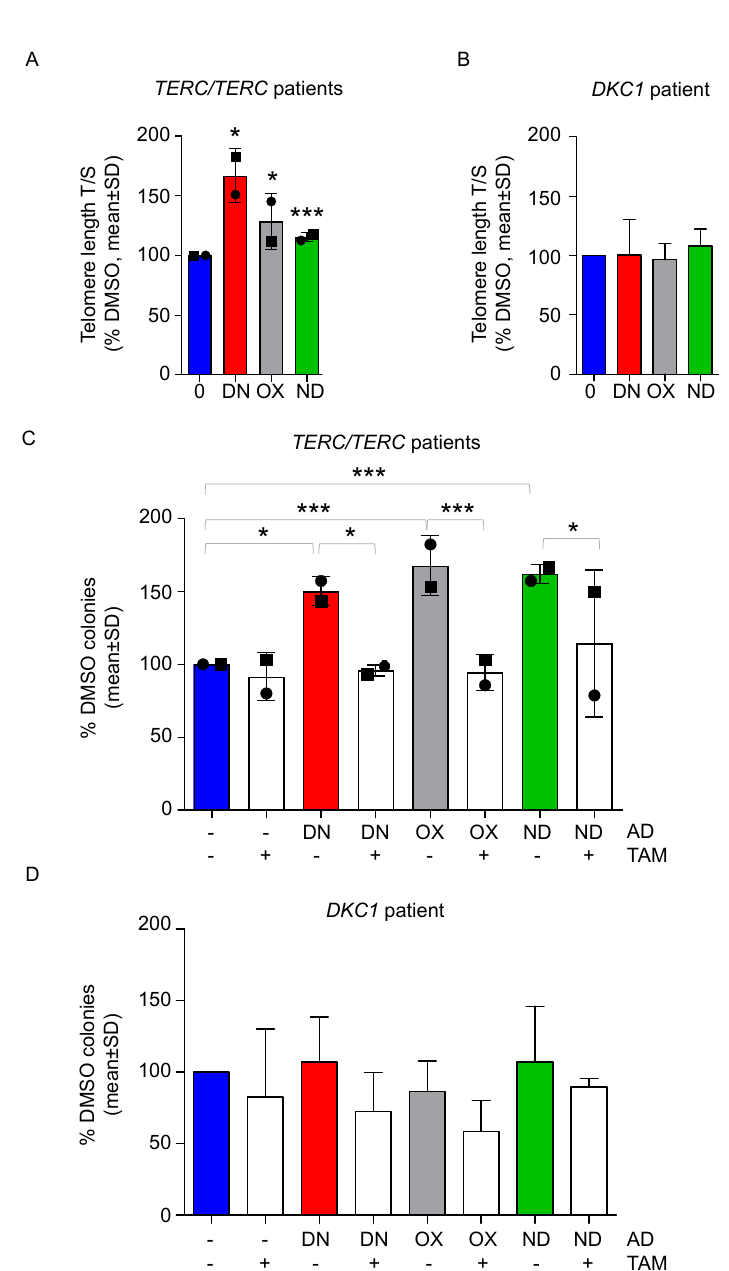
Figure 4. All androgens stimulate telomere elongation and tamoxifen reverts the positive e ff ects of ADs in DKC-derived BM-MNCs with TERT / TERC mutations. ( A ) DKC-derived BM-MNCs from patients #1 and #3 (represented by a circle and a square, respectively), were treated for 7 days with vehicle, danazol 150 nM (DN), oxymetholone 1 µ M (OX) and nandrolone 5 µ M (ND). Next, telomere length was measured via qPCR. One sample t -test was used to determine statistical significance. ( B ) The same experiment was repeated for patient #4 and telomere length is shown. ( C ) CFU assay was performed with BM-MNC treated with the following agents: danazol 150 nM (DN), oxymetholone 1 µ M (OX), nandrolone 5 µ M (ND), tamoxifen 1 µ M (TAM) and selected combinations, such as DN + TAM, OX + TAM, ND + TAM versus DMSO. The number of colonies was assessed after 7 days and normalized towards the control value. One-way ANOVA was used to determine statistical significance. ( D ) The same experimental layout of panel C was employed with BM-MNC from patient #4. Mean values ± SD are shown for all experiments. * p < 0.05, *** p <